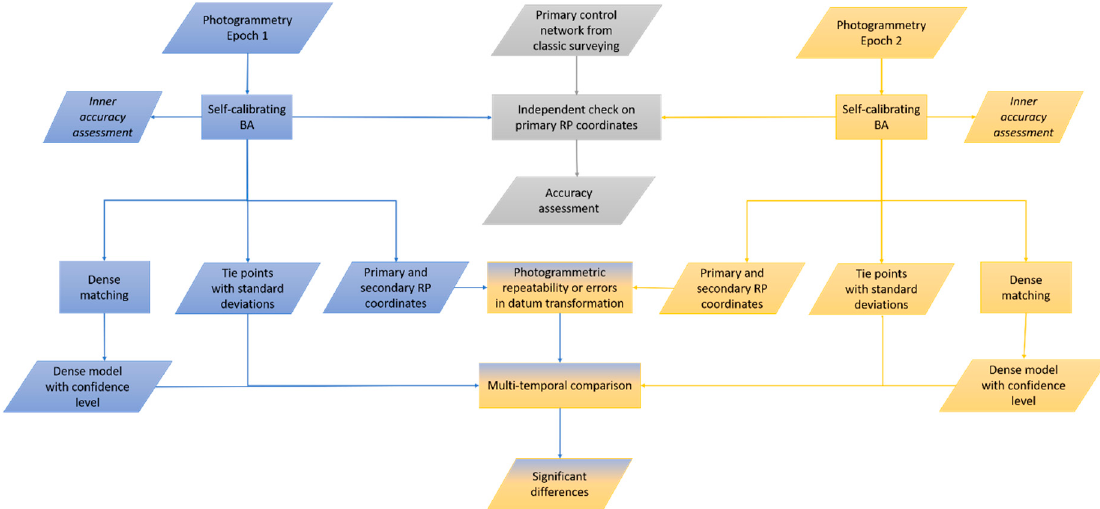
Figure 14. Developed approach for detection of significant changes in coral monitoring.